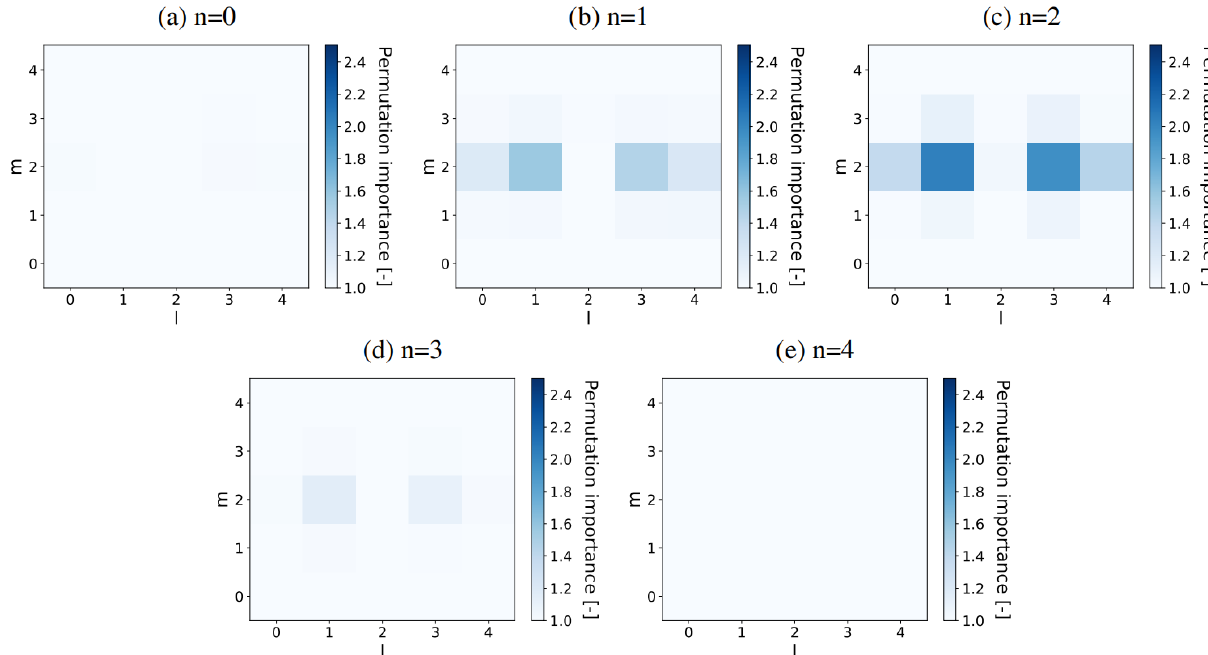
Figure 13. Permutation feature importance of all u velocities in the local input stencil (with indices l, m, n) associated with predicting τ in wu ( 55 . 3125 z + ) ) using an ANN (with n hidden = 64) trained and tested only on f hor = 8, averaged over three flow in the log layer (0 . 09375 z δ fields reserved for a priori testing and 10 random shufflings. The five panels (a–e) each show one of the five horizontal planes (indicated by their vertical index n ) present in the input stencils. τ in wu is located in the centre of the shown horizontal plane, halfway between n = 1 and n =